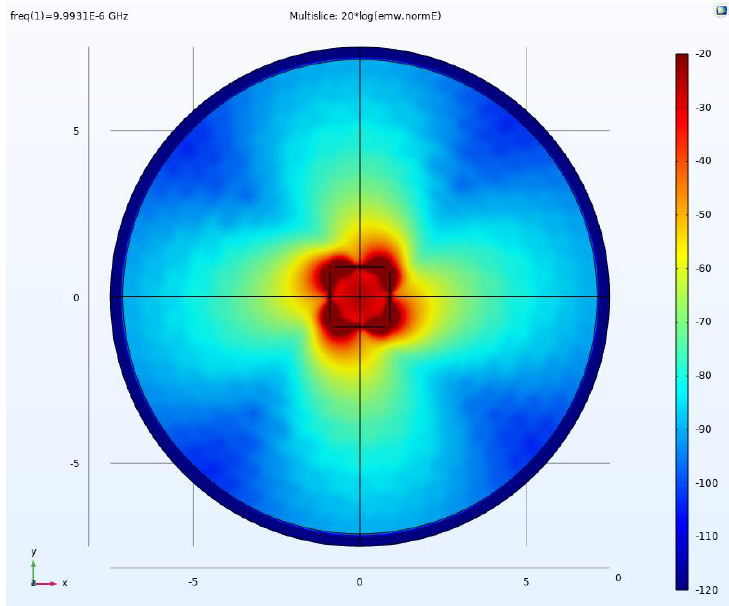
Figure 7. Electric field distribution on the MD plane.